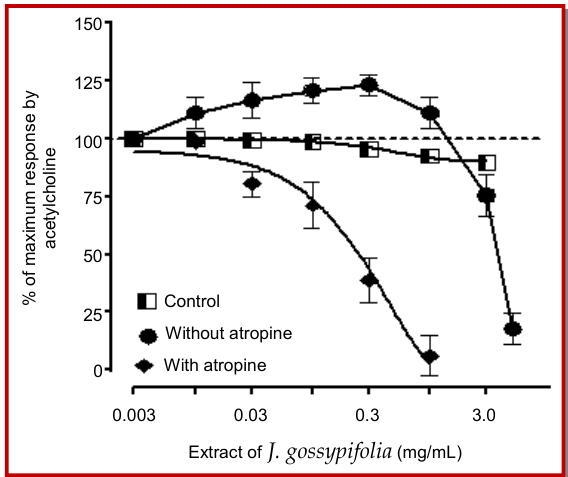
Figure 1: Concentration – response curves, showing the effect of J. gossypifolia in the absence and presence of atropine (0.1 µM) on spontaneously contracting rabbit jejunum preparation. The spasmogenic responses are expressed as percent of acetylcho- line maximum (values are expressed as mean ± SEM,